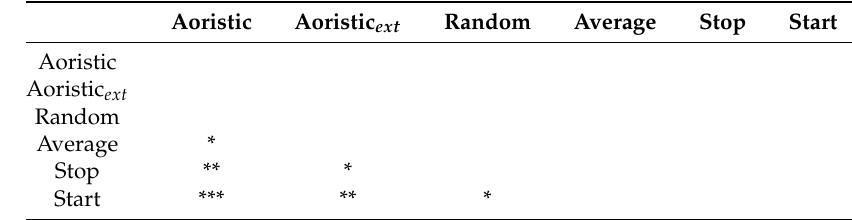
Table 7. Dunn significance test results from pair-wise comparisons between temporal analysis methods over the χ 2 weekday